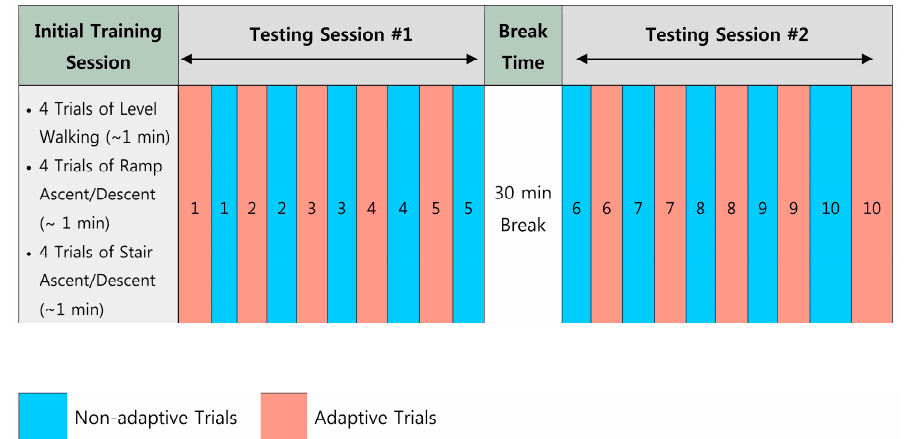
Figure 8. Illustration of experimental protocol design for evaluating adaptive locomotion recognition on online prosthesis control.